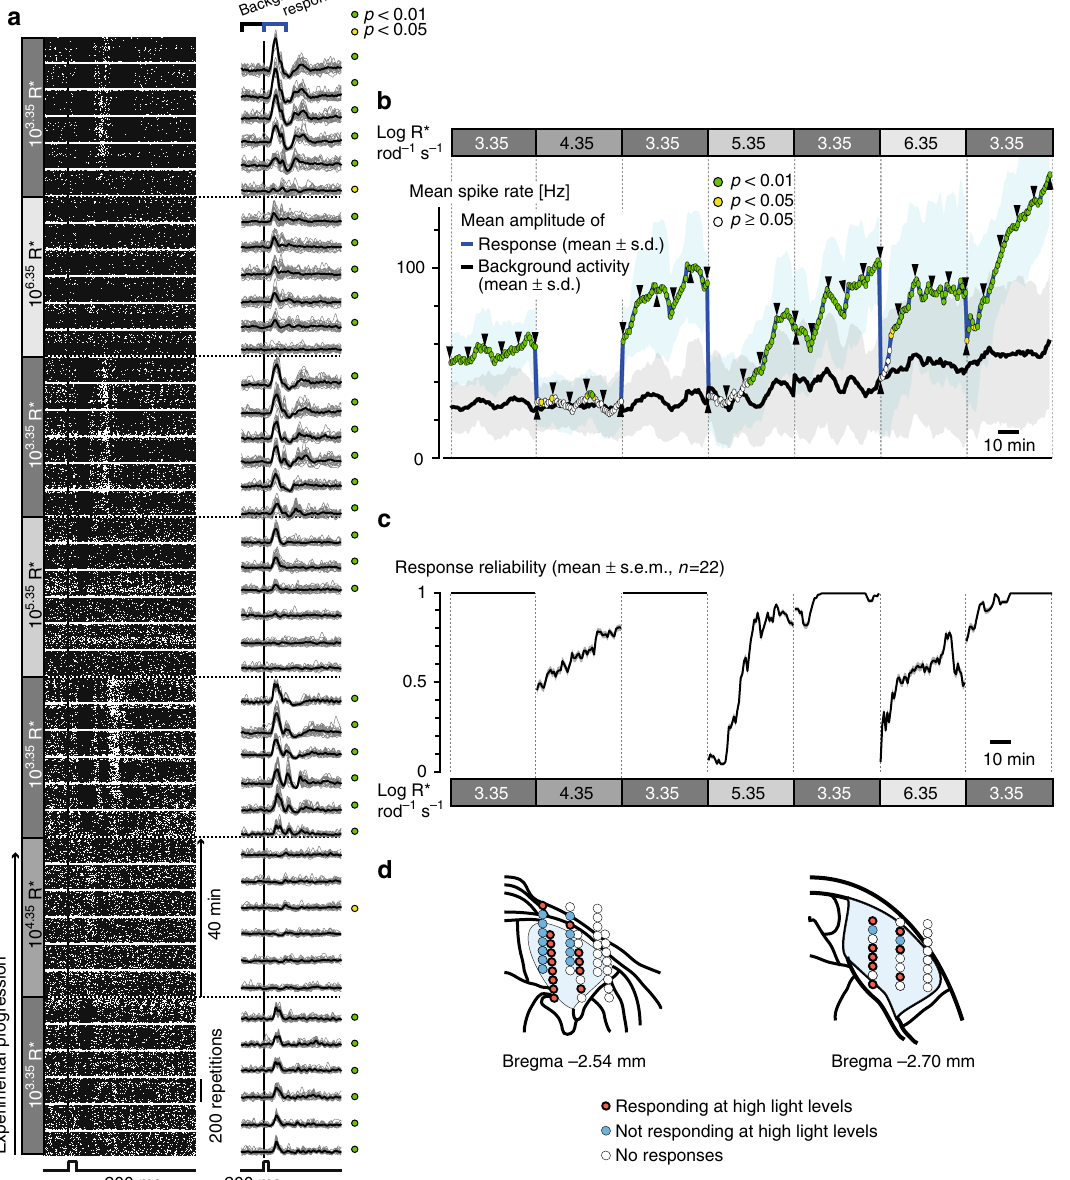
Fig. 4 Rod responses in in vivo dLGN recordings in Cnga3 − / − . a Example response of one multiunit to a 50 ms fl ash at different light levels. Responses to each of the 8400 single repetitions are shown in the raster plot (left). For analysis, 10 consecutive repetitions were averaged (one “ group ” , gray lines on the right). In black, the averages over 20 such groups (200 fl ashes) are shown. b Response amplitude (blue curve) and background activity (black curve) of the multiunit shown in a (moving average over runs of 20 groups ( = 200 fl ashes), shifted by one group. Arrowheads mark values corresponding to the raw traces shown in the right column in a ). Responses signi fi cantly above background are color-coded in green ( p < 0.01) and yellow ( p < 0.05, rank sum test). This example multiunit stops responding after switching to 10 4.35 R* rod − 1 s − 1 . However, at 10 5.35 and 10 6.35 R* rod − 1 s − 1 the responses reappear after several minutes. c Population data for those multiunits responding at high light levels ( n = 22/36, mean ± s.e.m.), depicting the reliability of their responses (Methods; Supplementary Fig. 1a). Responses at high light levels recovered with an intensity-dependent time course. d Electrode positions during LGN recordings. Electrodes on which responses recovered at high light levels are color-coded in red, electrodes with responses only at moderate light levels are colored in